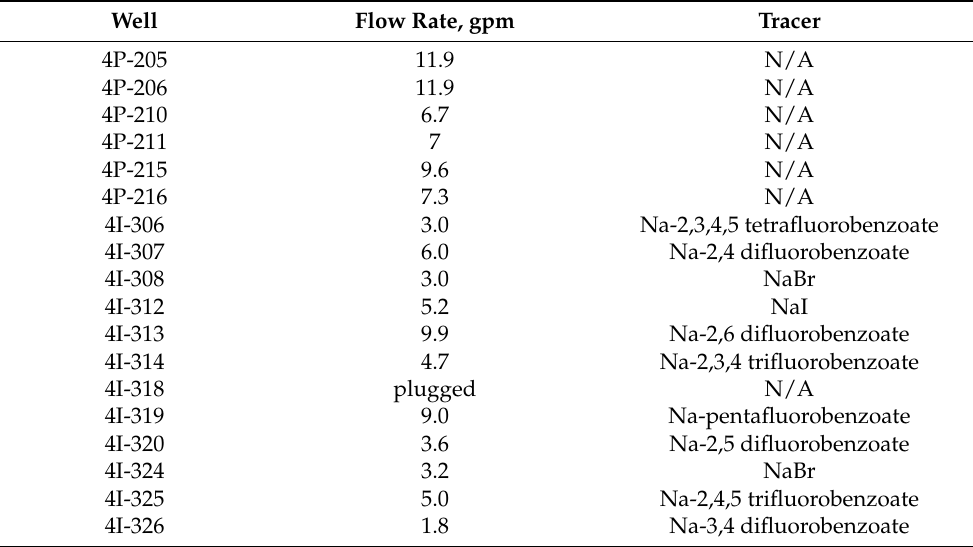
Table A5. Target flow rates and tracers injected into each injection well for the HH 4-11 tracer test. All tracer injection masses were ~5 kg (as sodium salts).